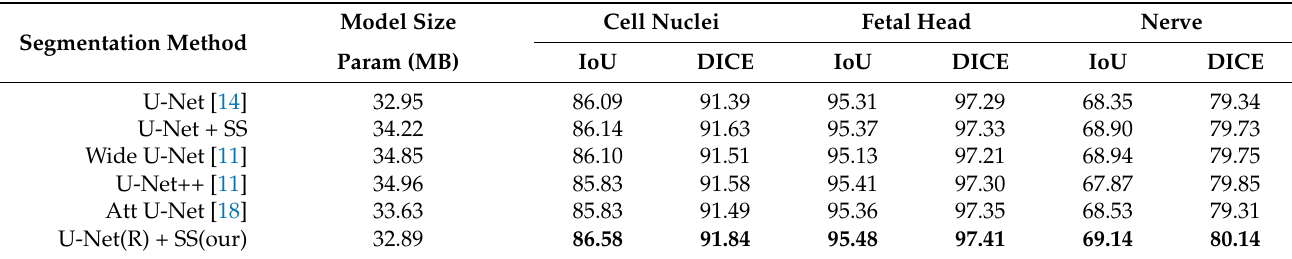
Table 3. Performance comparison for medical image segmentation with various U-Net mechanisms. The Intersection over union (IoU) and Dice coefficients are employed as comparison metrics (%). Numbers in bold indicate the highest performance in each